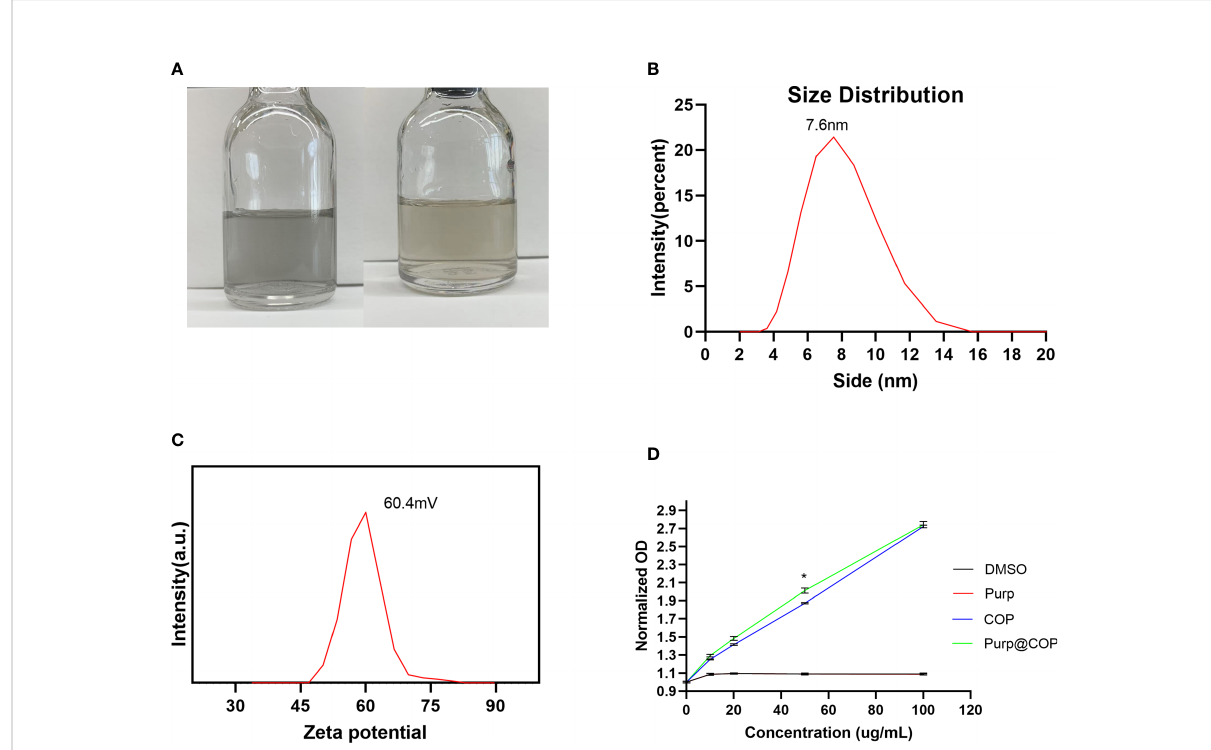
FIGURE 1 Solubility test. (A) The photo of Purp@COP dispersed in water for 1 day (left) and 2 weeks (right). (B) Size distribution of Purp@COP in water at 25°C. (C) Zeta potential of Purp@COP in water at 25°C. (D) The absorption intensity at 808 nm for Purp, COP, and Purp@COP. The p value is less than 0.05, meaning that there is statistically signi fi